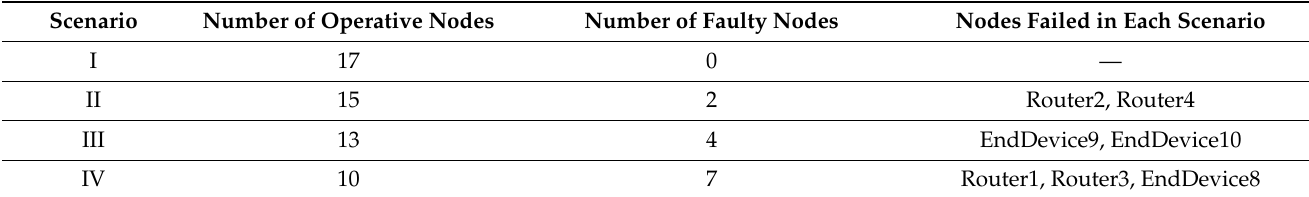
Table 1. Analyzed scenario descriptions.